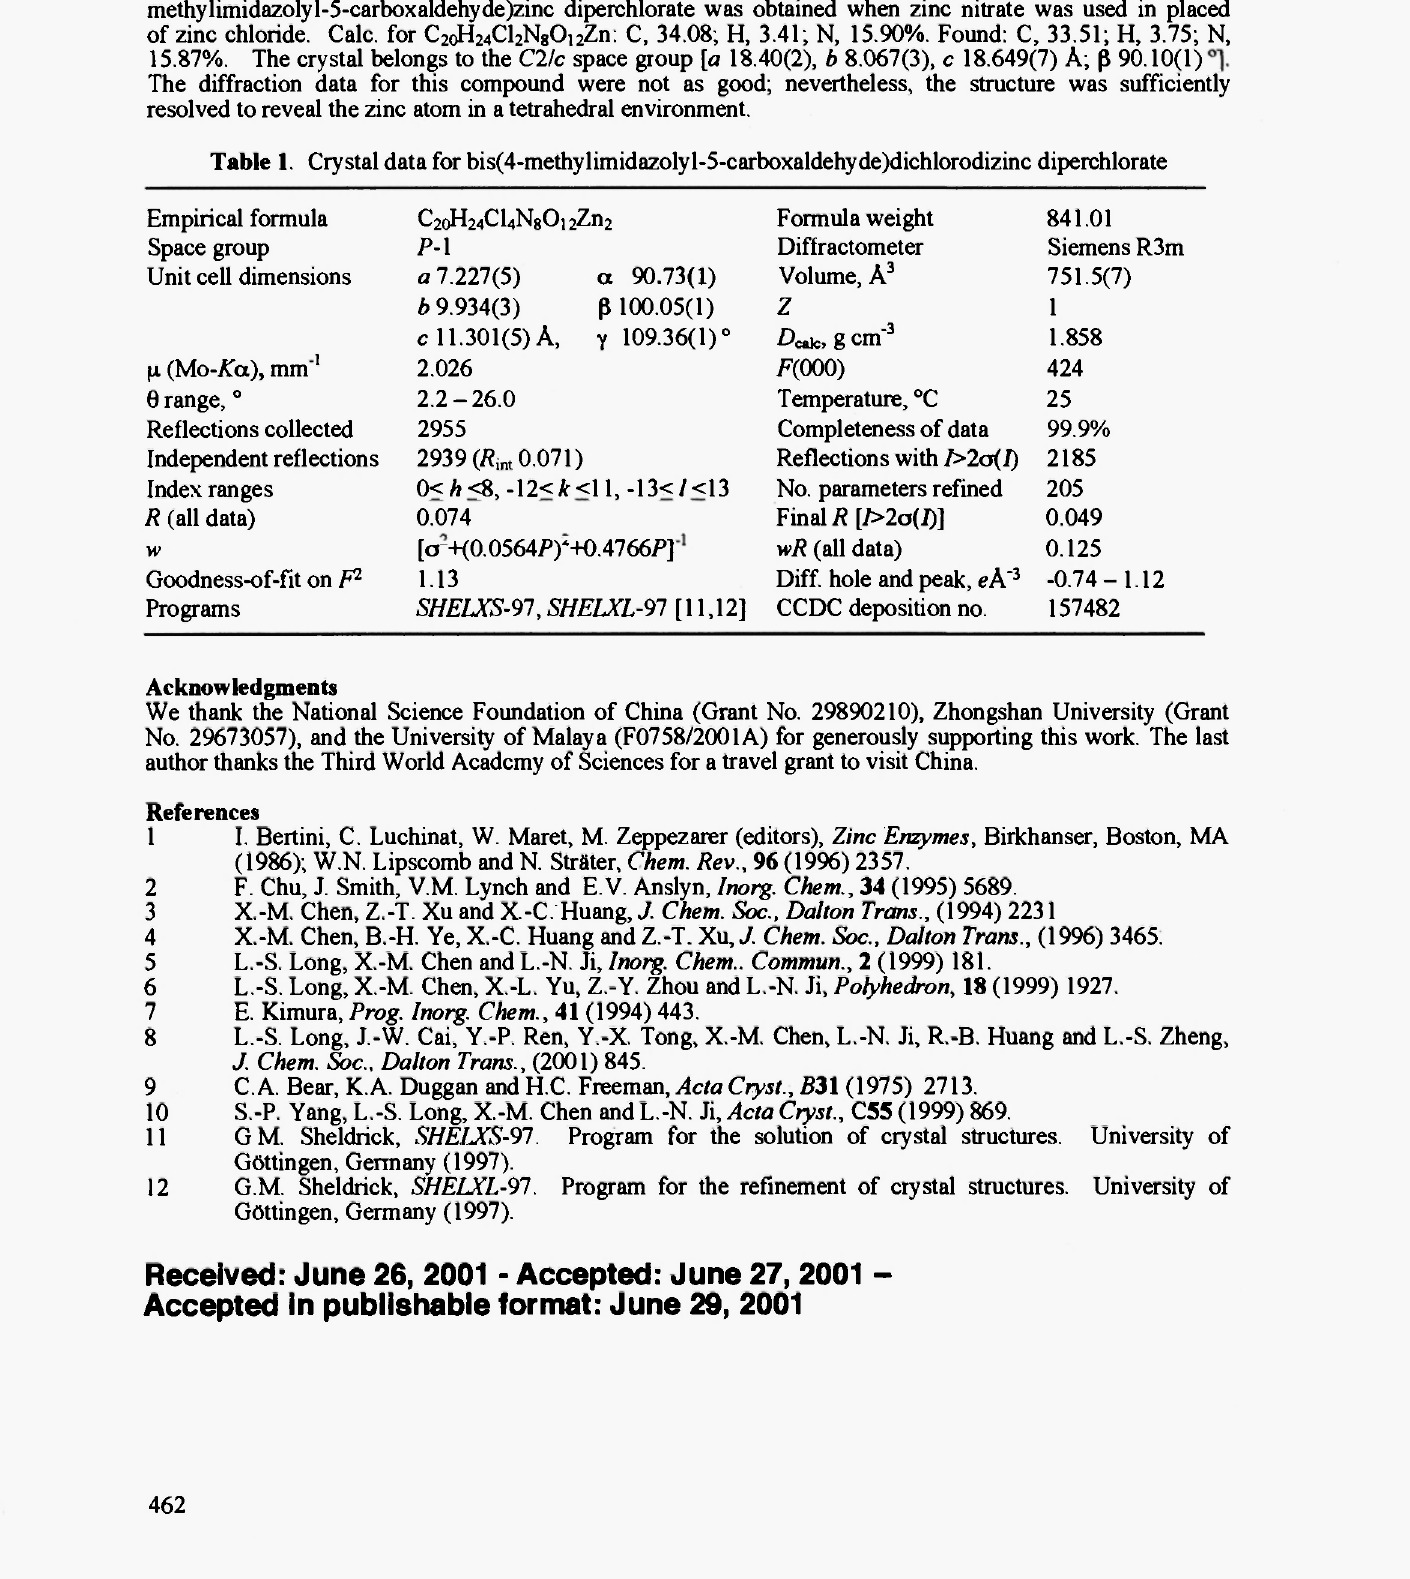
Table 1. Crystal data for bis(4-methylimidazolyl-5-carboxaldehyde)dichlorodizinc diperchlorate Empirical